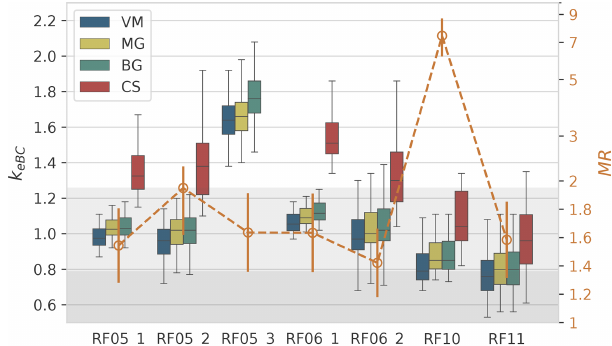
Figure 4. Box plot of k eBC (left axis) derived from different models and the MR values (orange open dots, right axis) for each flight. Er- ror bars of MR represent 20% uncertainty. The right y axis uses the log scale. The light and dark grey shaded region shows k eBC smaller than 1.26, the largest k BC value determined by Moteki et al. (2010), and 0.79, the largest value of commonly used k BC ,